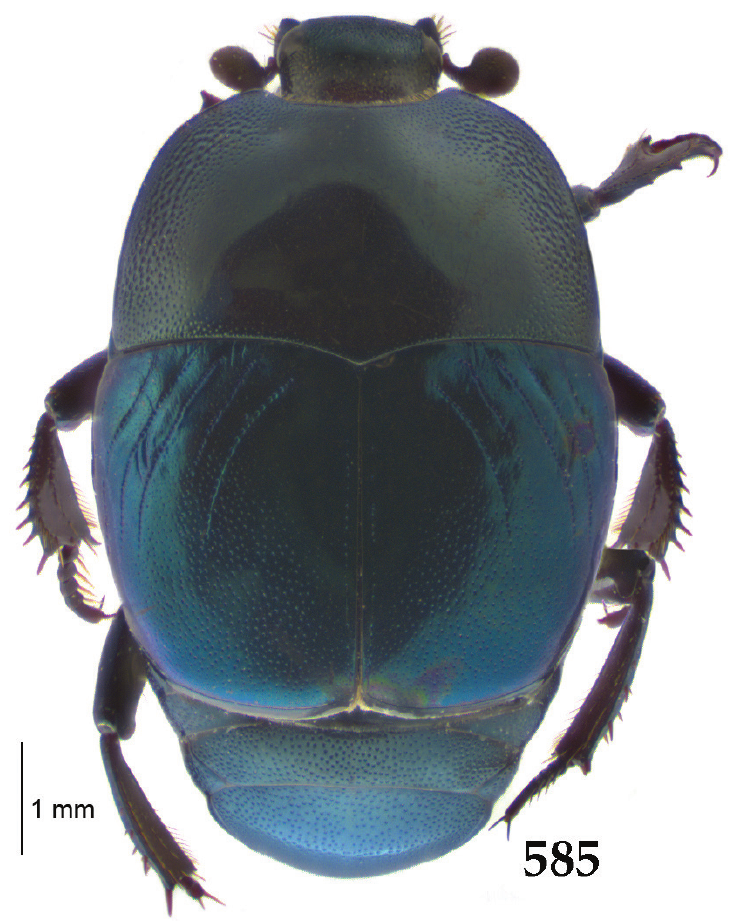
Figure 585. Saprinus ( Saprinus ) viridanus Lewis, 1899 habitus, dorsal